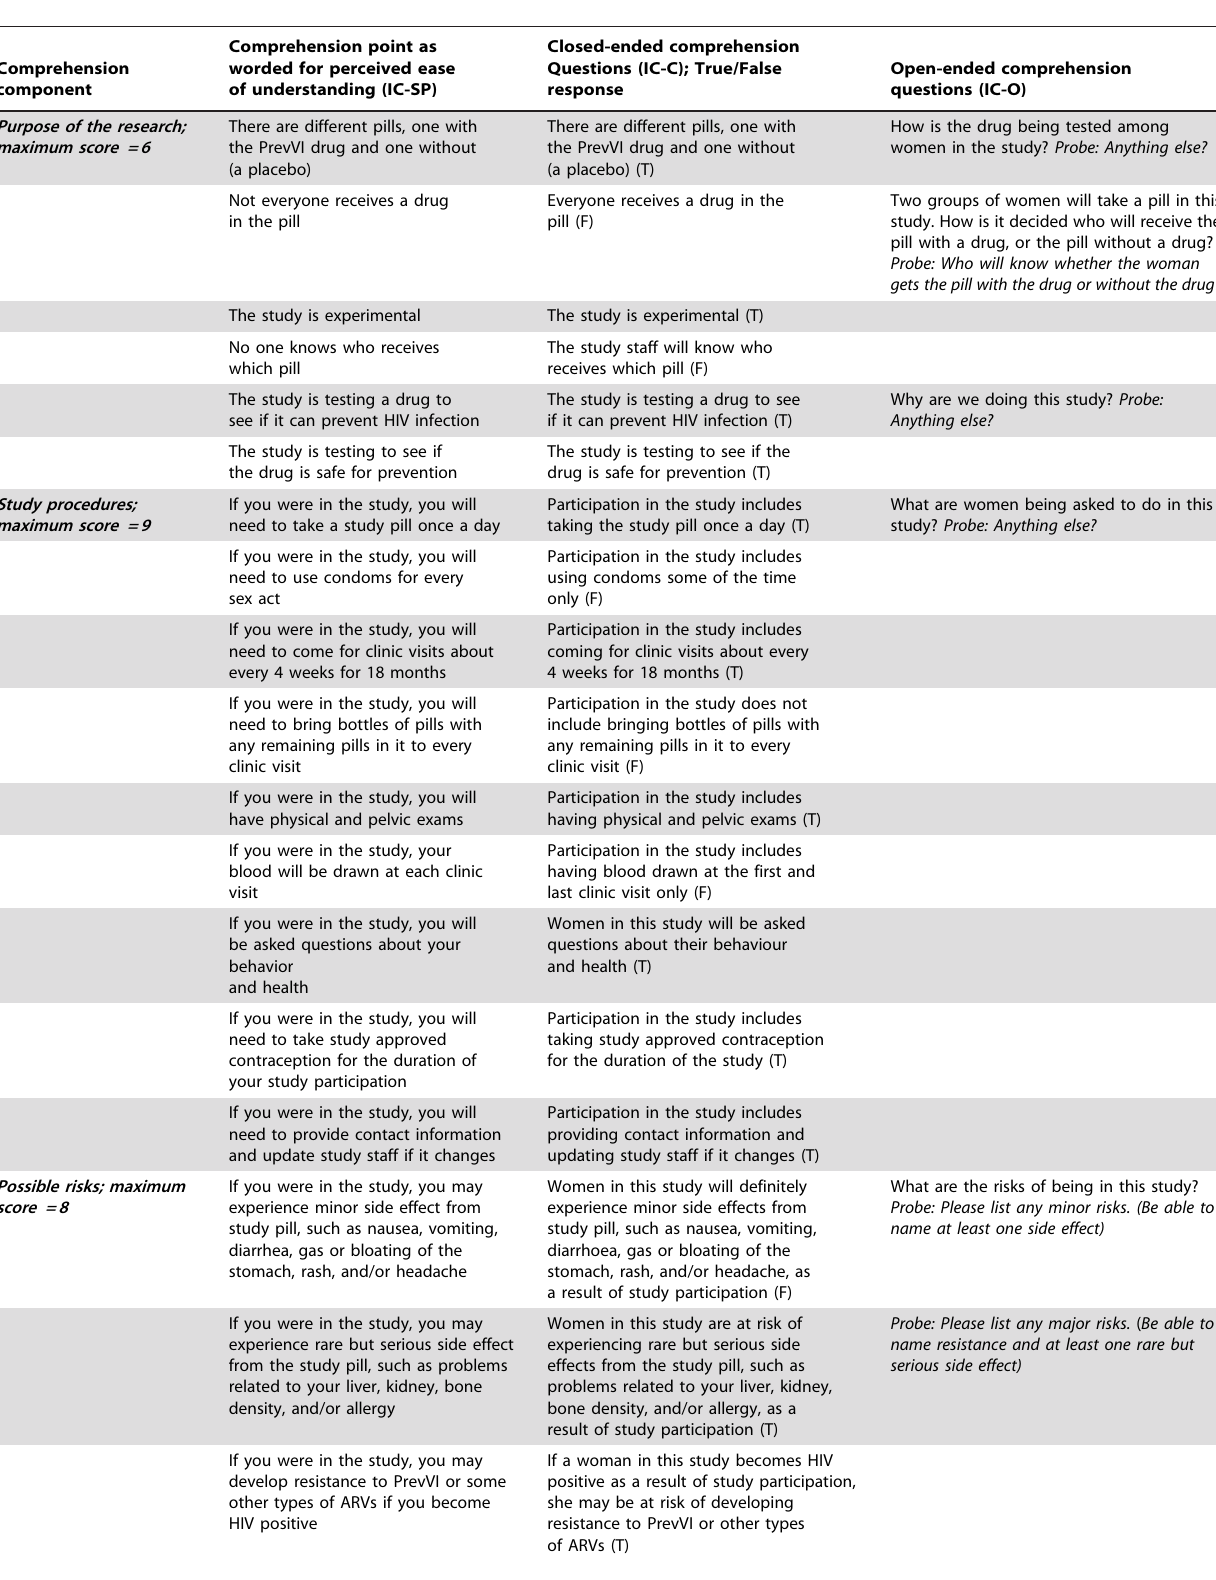
Table 1. Informed consent comprehension components, points, and associated